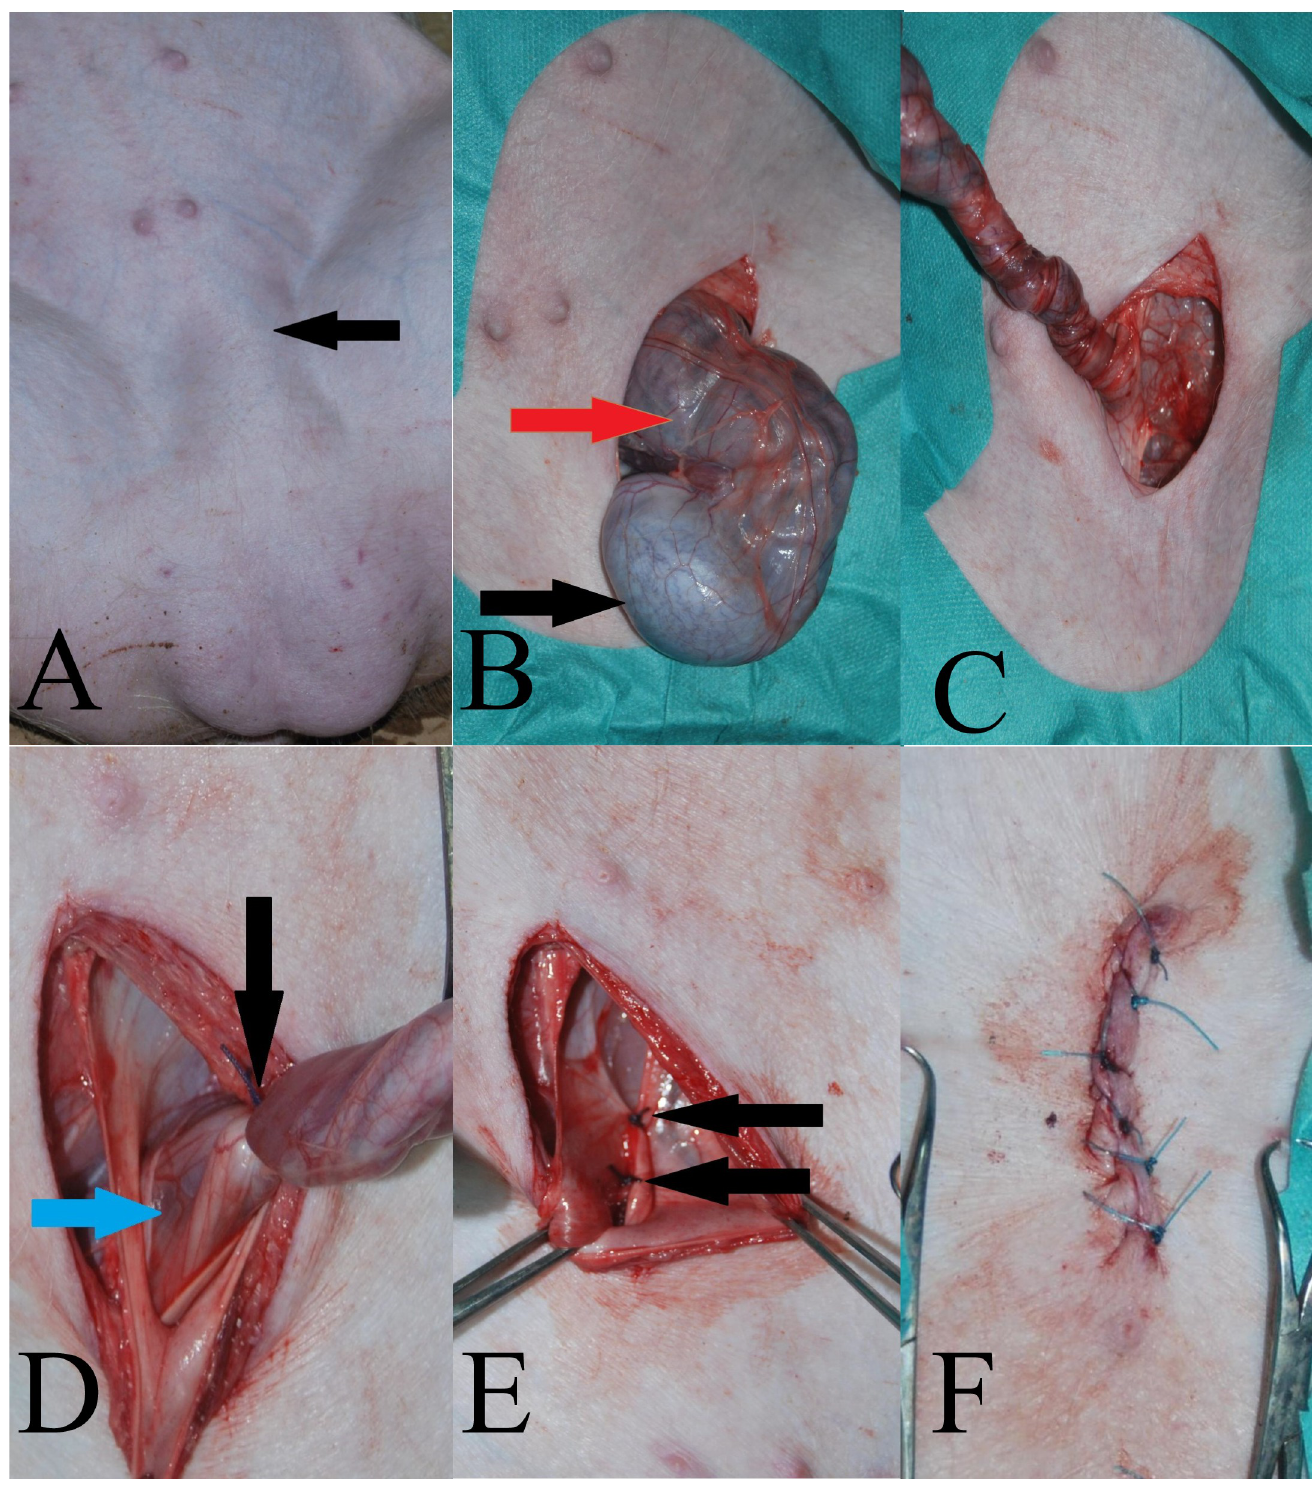
Fig 1. A—Pre-operative appearance of left inguinal hernia—black arrow. B—Intraoperative appearance of the vaginal process with the testicle (black arrow) and hernia contents (red arrow). C—Intraoperative appearance of a twisted vaginal process to drain the contents of the hernia into the abdominal cavity. D— Intraoperative appearance of a twisted vaginal ridge with a ligature just next to the external inguinal canal. E—Intraoperative appearance of the closed external inguinal ring with single broken sutures (arrows). F—The appearance of the postoperative wound at the level of the inguinal canal immediately after the procedure.